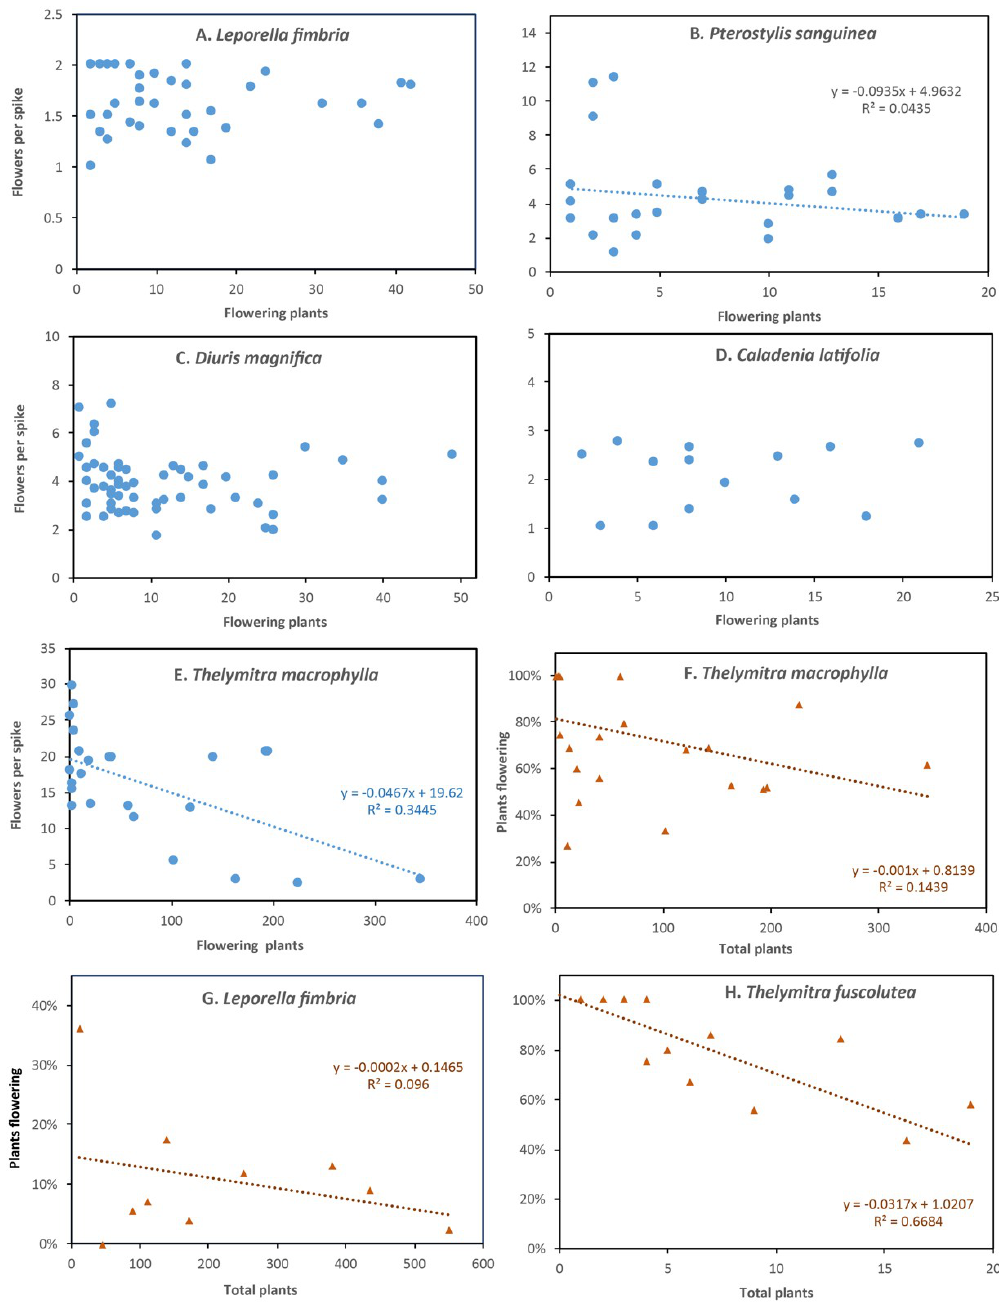
Figure 7. Relationships between plant density and flower production, or flowering plants relative to total plants. Figures A–E show number of flowers per spike relative to numbers of flowering plants within a 5 m radius for Leporella fimbria ( A ), Pterostylis sanguinea ( B ), Diuris magnifica ( C ), Caladenia latifolia ( D ) and Thelymitra macrophylla ( E ). Figures F,G,H show proportion of flowering plants relative to or total plants in the same areas for T. fuscolutea ( F ), L. fimbria ( G ) and Thelymitra macrophylla ( H ).